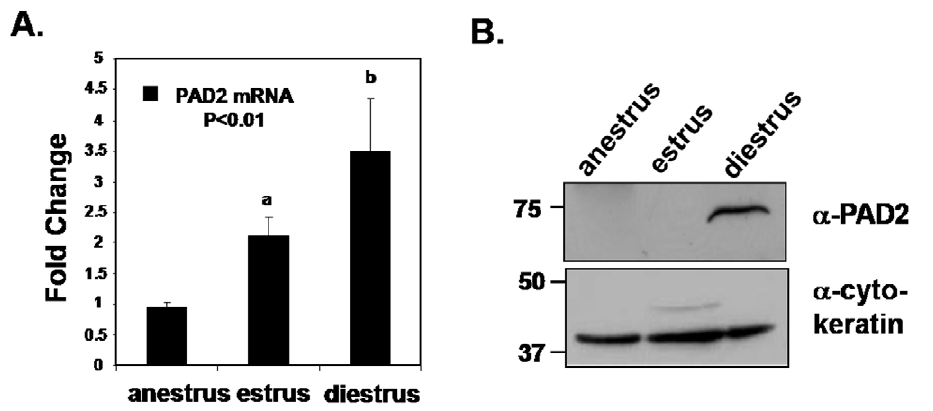
Figure 2. PAD2 mRNA and protein are differentially expressed across the canine estrous cycle with highest levels detected during late diestrus. (A) RNA was purified from canine mammary tissue samples, reverse transcribed and resulting cDNA was used in qPCR reactions with intron spanning primers specific for the 75 kDa isoform of PAD2 and RPS5, a characterized canine reference gene. All values are normalized to anestrus samples and bars represent the means 6 SEM. Means were separated by one-way ANOVA using Tukey’s HSD and the letters a and b represent significant differences (P , 0.01). (B) Canine mammary tissue samples from anestrus, estrus/early diestrus and late diestrus were subject to SDS-PAGE and probed with an anti-PAD2 antibody which detected a 75 kDa band, the estimated molecular weight of PAD2.